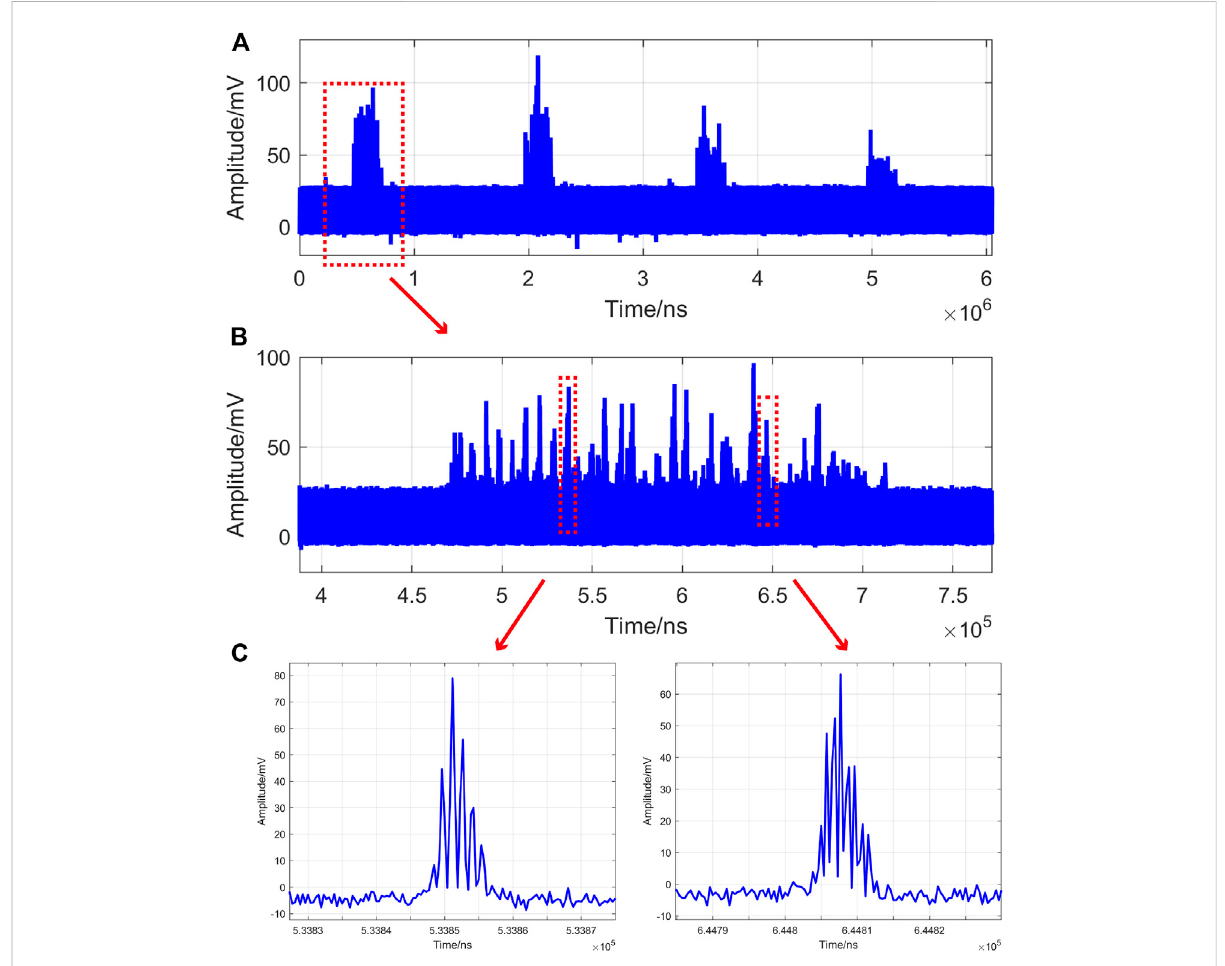
FIGURE 3 Dynamicclearancemeasurementsignals. (A) Thesignalsofseveralblade tips. (B) Thesignalsofonebladetip. (C) Thesignalsofthetwofacesof step in one blade